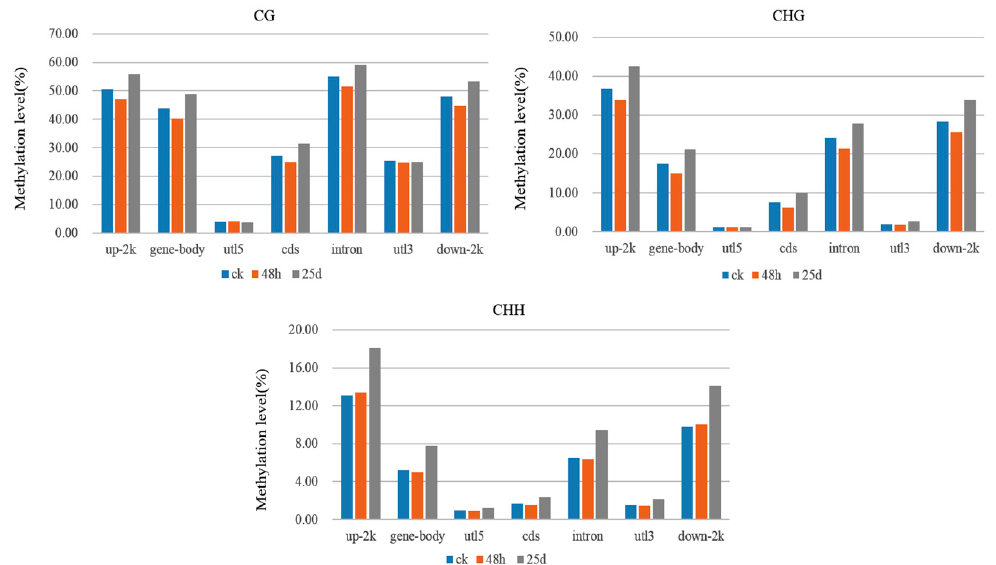
Figure 6. DNA methylation levels in different genomic functional regions of the watermelon genome. The x -axis represents the genomic regions in the watermelon genome. utl5: 5 (cid:48) untranslated region, cds: coding sequence, utl3: 3 (cid:48) untranslated region, up-2k: 2 kb upstream of genes, down-2k: 2 kb downstream of genes. The y -axis represents the methylation levels for ck, 48 hpi, and 25 dpi libraries under CG, CHG, and CHH